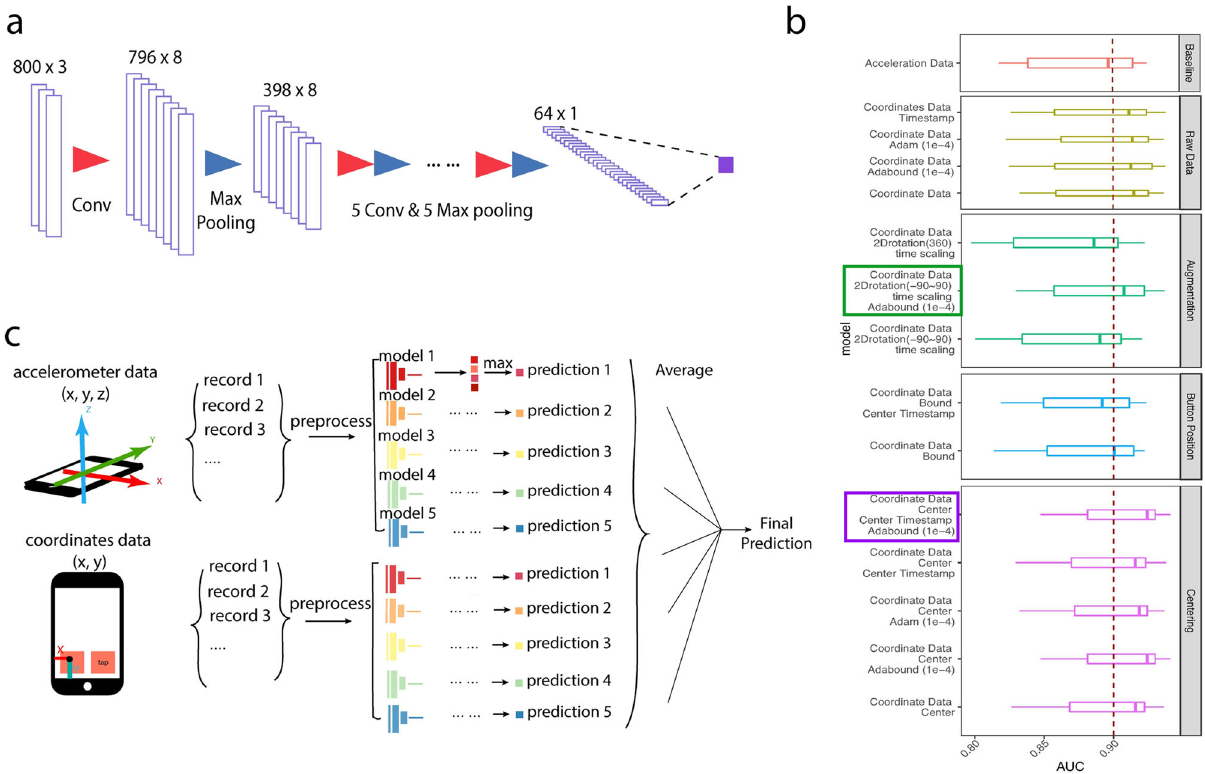
Fig. 3 Model design for tapping coordinate data. a depicts the model structure for the coordinate data tapping model (inputs: x , y coordinates and timestamp). The model contains six convolutional layers, six max-pooling layers, and one fully connected layer. b Experiments were designed to search for the optimal data processing methods and network hyperparameters, including the normalization strategy on the coordinates and the timestamps, augmentations with 2D-rotation and time scale, and the network optimizer. Best performing models by augmentation and centering groups are enclosed in squares. c A combined model is generated by averaging the prediction scores from accelerometer and from